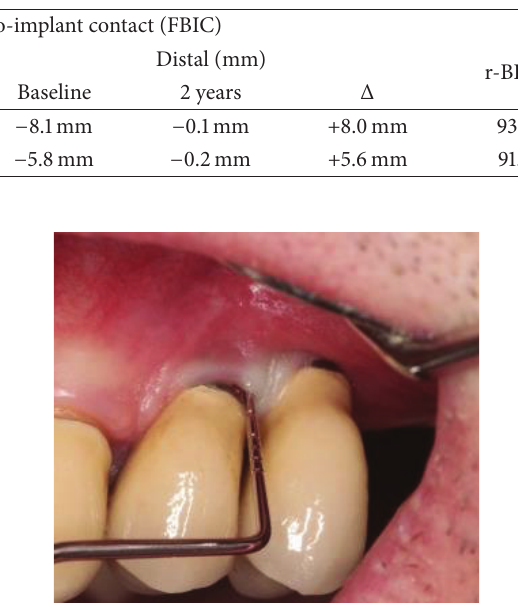
Figure 13: One-year postoperative radiographs depicting radiopac- ity at the location of the defect.